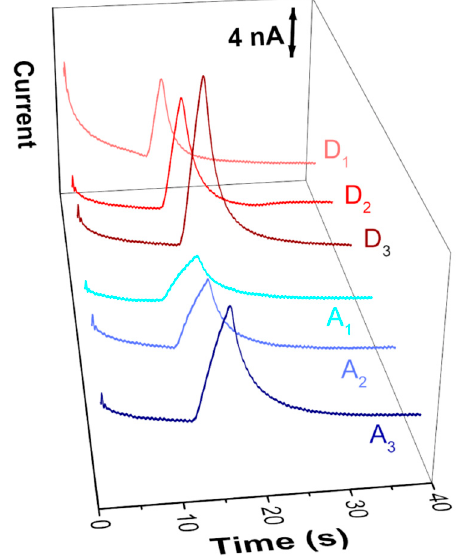
Figure 5. Electropherograms showing the detection of nitrite in aquarium water samples (A1–A3) and fish breeding dam water samples (D1–D3). Injection: − 800 V for 10 s; Separation: − 1000 V for 60 s. For the other conditions, see Figure 3.